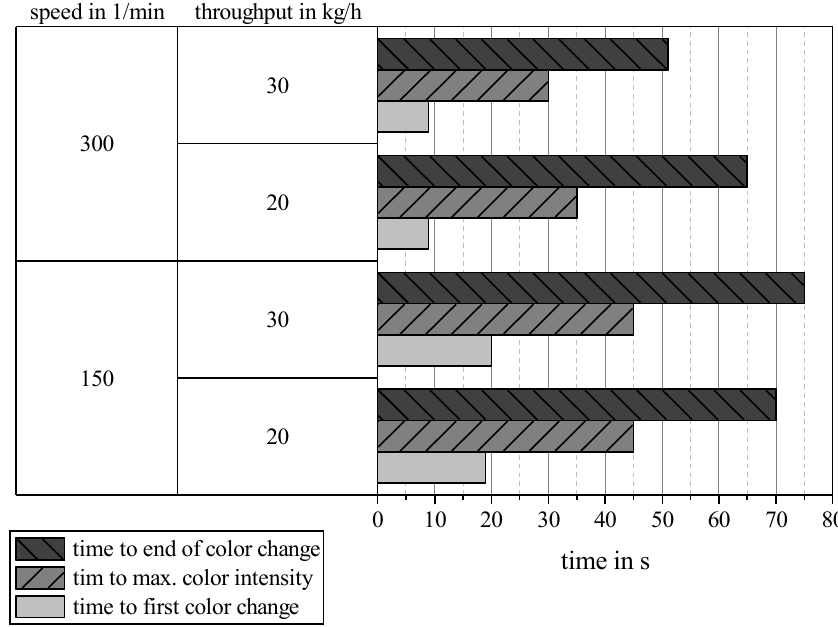
Figure 8. Residence time distribution for the selected process parameter combinations.